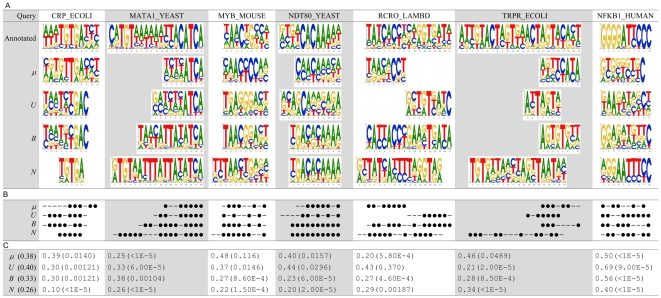
Predictions using different complexes.
μ: the proposed method. U: the second synthetic complex that eliminates the second type of structural variation. B: the third synthetic complex that eliminates the second and third types of structural variation. N: native complexes. (A) PWMs. (B) A position is marked as ‘•’ if its most favorable base type was correctly predicted, or marked as ‘–’ otherwise. (C) Ψ-scores and the corresponding p-values. The value within the parentheses of the first column indicates the average Ψ-score.